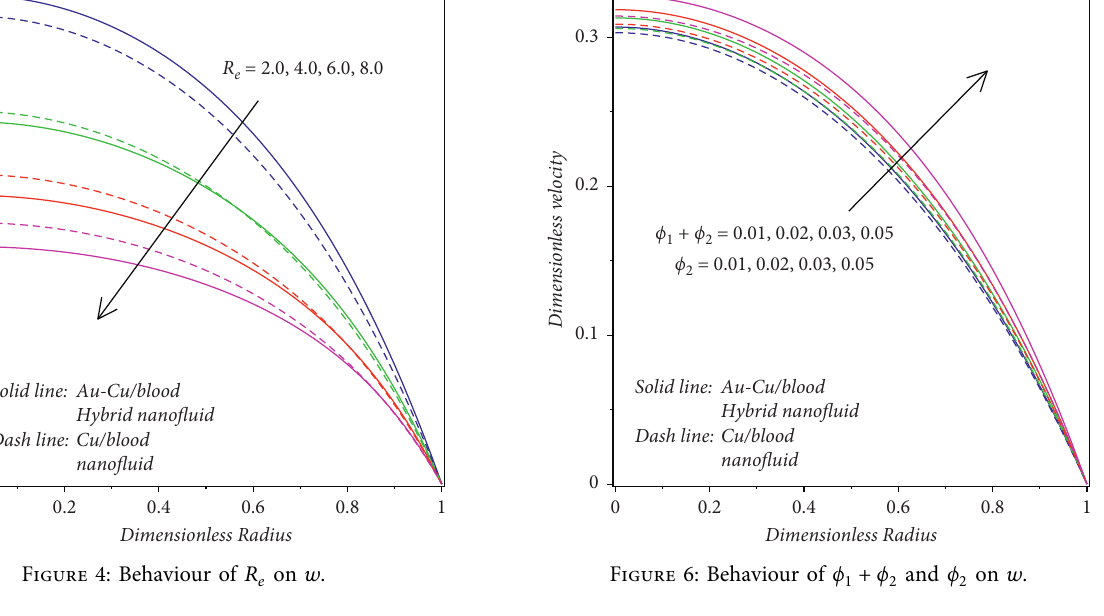
+ ϕ and ϕ on w . 1 2 2